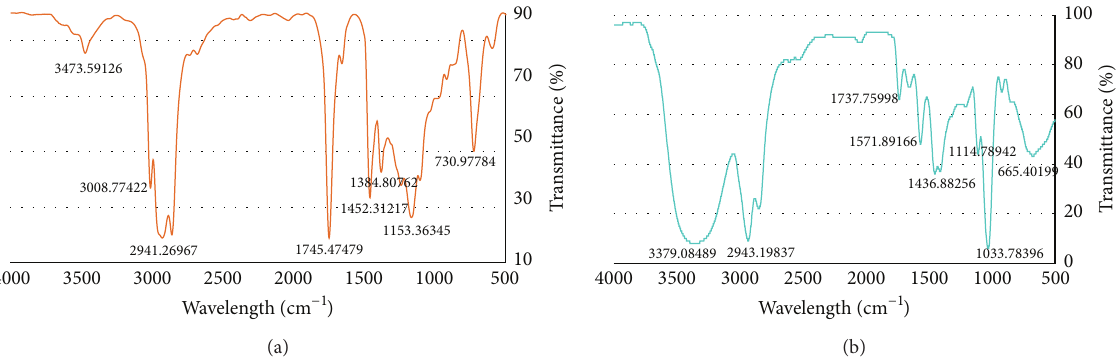
Figure 8: (a) FT-IR spectrum for waste vegetable oil. (b) FT-IR spectrum for biodiesel produced at optimum conditions.